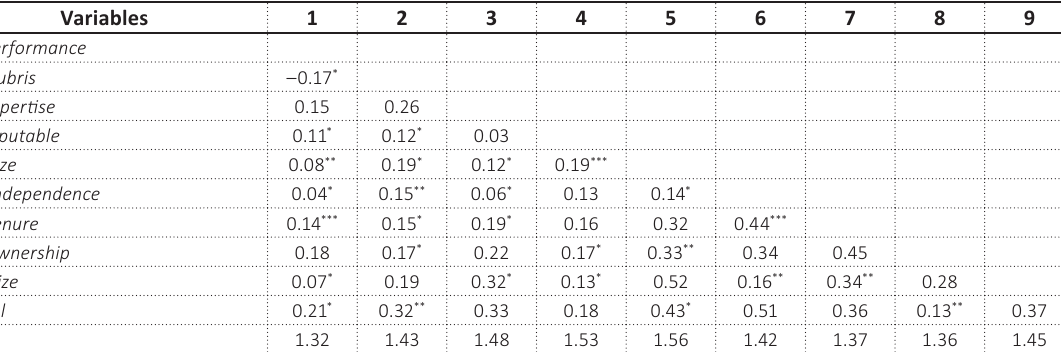
Table 4. Pearson correlation matrix for all